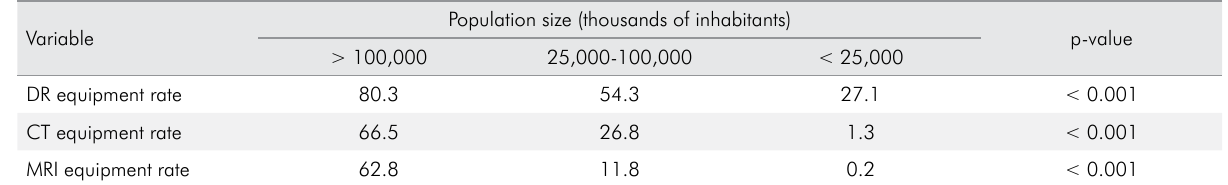
Table 2. Percentage of municipalities that increased the rate of imaging equipment from 2005–2007 to 2014–2016 by city population size (n = 5,564).